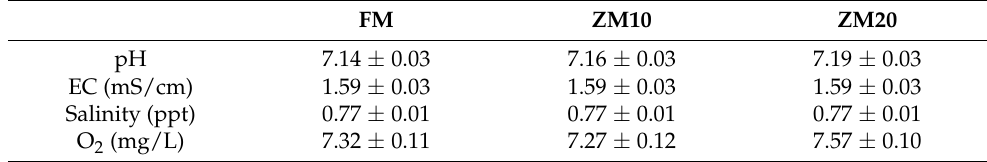
Table 2. Water physicochemical parameters in the fish tanks over the 45-day period.